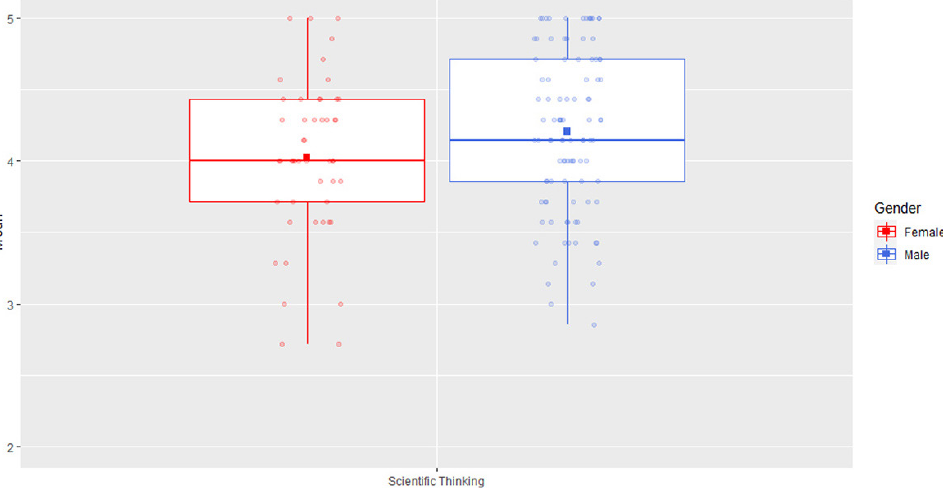
Fig. 8. Boxplot analysis: scientific thinking sub-competency by